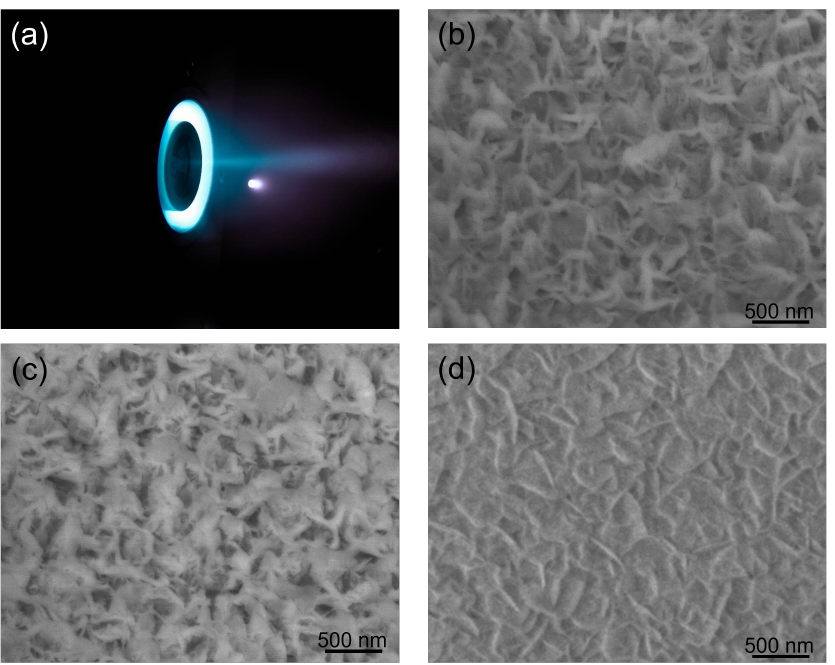
Figure 6. Photograph of the 150 W Hall effect thruster ( a ) during its stable working state and SEM images of BNNS samples with the different etching durations: ( b ): 40 h; ( c ): 80 h; and ( d ): AO etching 40